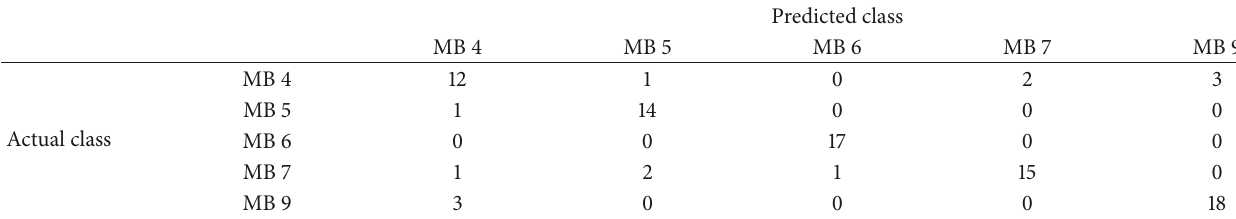
Table 4: Confusion matrix from decision tree in the testing process.